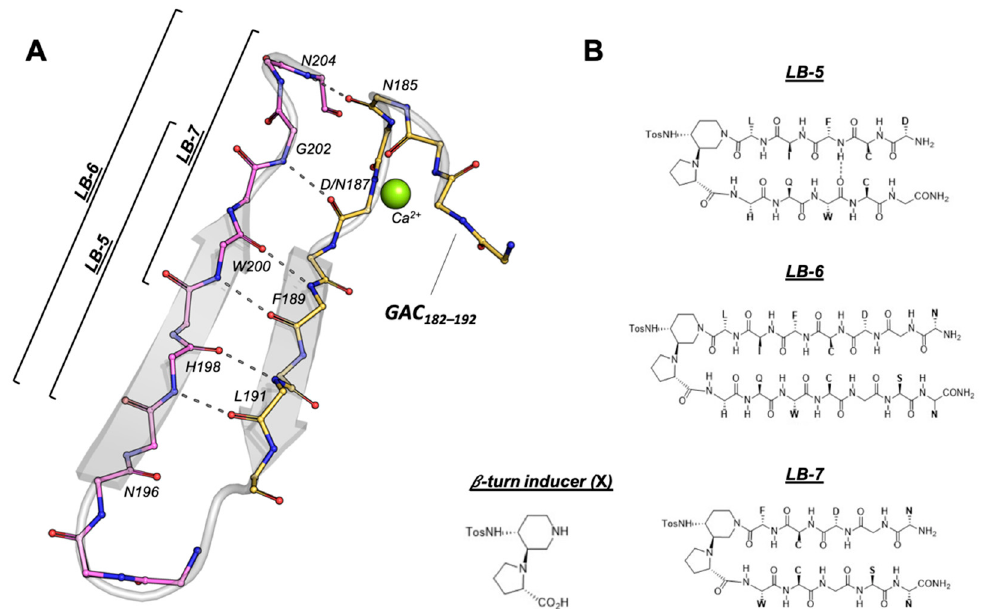
Figure 1. Design and structure of the LB peptidomimetics. ( A ) Backbone conformation and localization of the GAC 182–192 in the context of the native 3D structure of GSN G2 (pdb id 6QW3 [32]). The flanking sequence spanning residues 194–204 used as a template to design the peptidomimetics is also shown. ( B ) Chemical structure of the peptidomimetics LB-5, LB-6, and LB-7 and of the β -turn inducer.